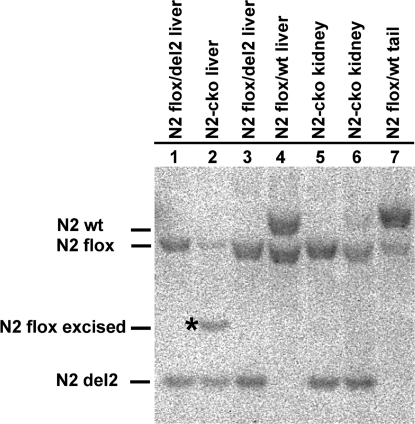
Conditional excision of the Notch2flox allele by the Alb1-Cre transgene.Southern blot of SacI/EcoRI- digested DNA isolated at P4. Excision of the Notch2flox allele (asterisk indicates the excised allele) was observed only in liver DNA of Notch2-cko mice (lane 2), but not in kidney DNA of Notch2-cko mice (lanes 5,6). Genotype of Notch2-cko mice is Notch2flox/Notch2del2; Alb1-Cre/+.